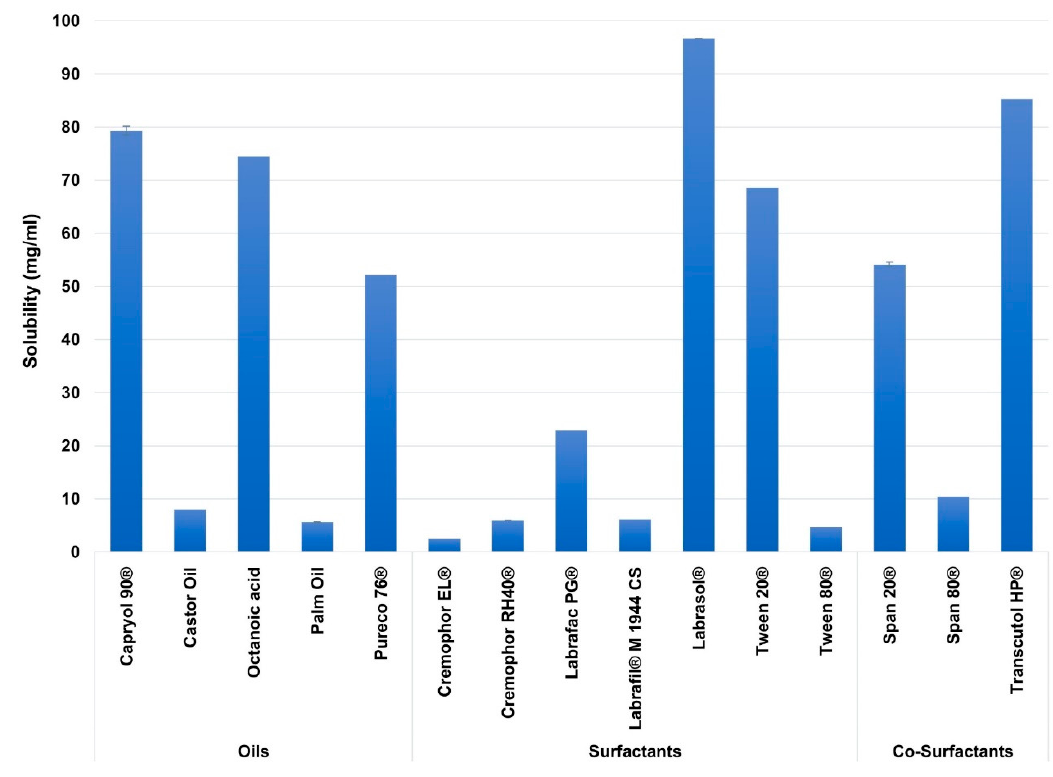
Figure 2. The solubility of Azithromycin (AZM) in the different screened excipients. Mean ± SD, n = 3. Among the studied excipients, the highest solubility of AZM was observed in the oils of Capryol ® 90 (80.16 ± 0.83 mg / mL), and Octanoic acid (74.5 ± 0.035 mg / mL), in the surfactants of Labrasol ® (97.44 ± 0.7 mg / mL), and Tween 20 (69.43 ± 0.81 mg / mL) and in the co-surfactants of Transcutol ® (85.41 ± 0.27 mg / mL), and Span 20 (53.48 ± 0.75 mg /